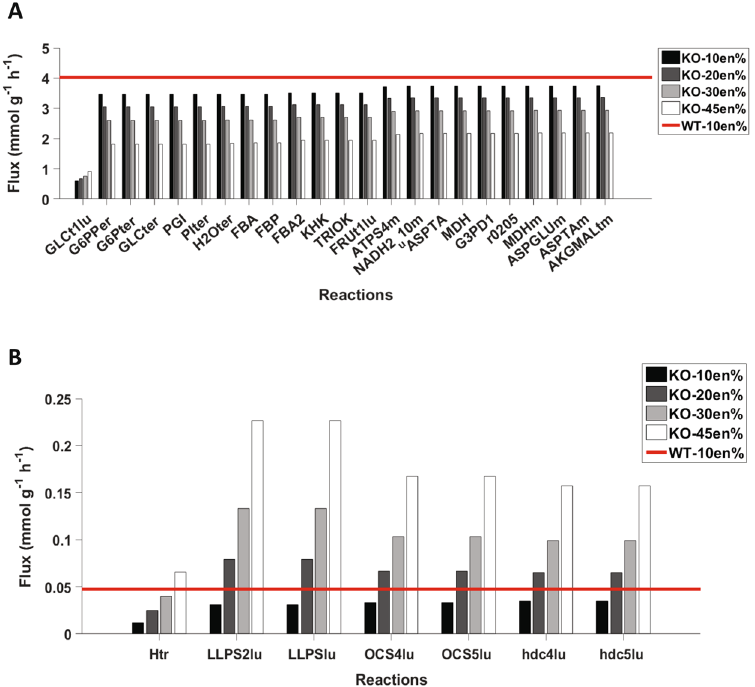
Figure 6. Reaction knockout for glucose and TAG. ( A ) Impact of reaction deletions on maximal glucose secretion. ( B ) Impact of reaction deletions on maximal TAG in chylomicrons